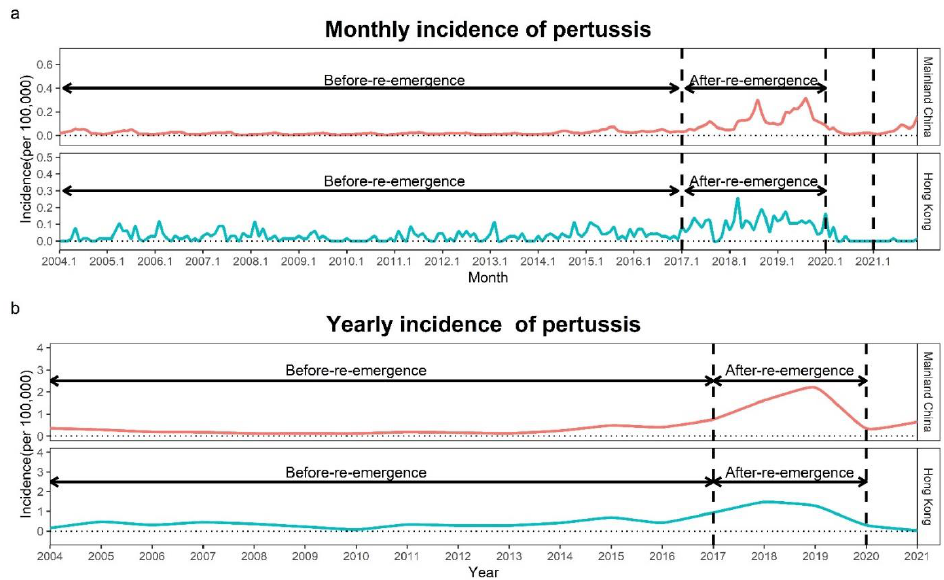
Figure 2. Yearly and monthly incidence rates (1/100,000) of pertussis in the period 2004–2021. ( a ) Monthly incidence of pertussis; ( b ) yearly incidence of pertussis. Before-re-emergence: 2004 – 2016; after-re-emergence: 2017 – 2019.